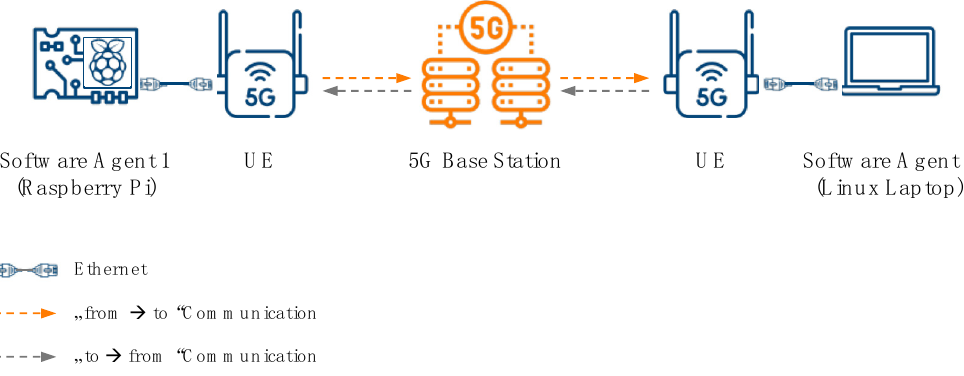
Figure 4. Experimental setup for 5G performance measurements with ping and Hawkeye test.